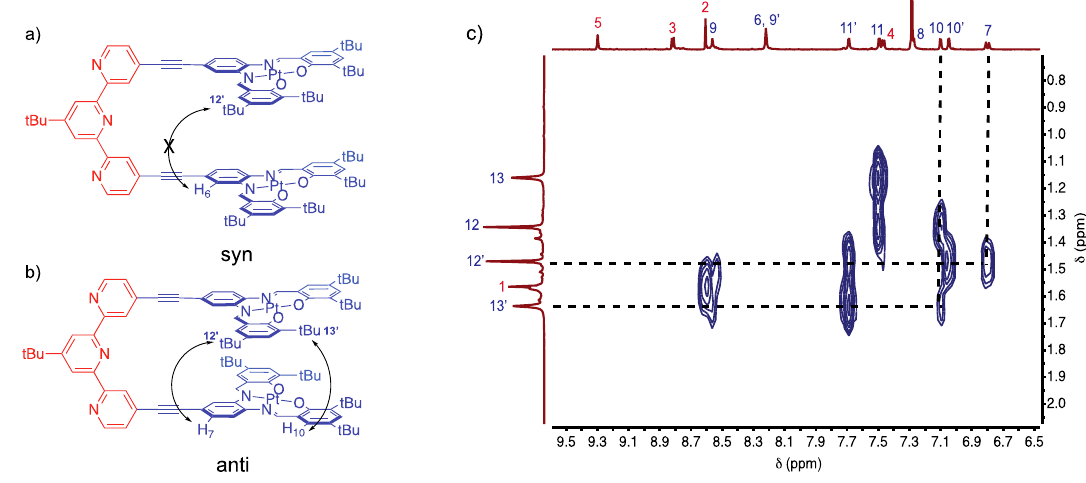
Figure 2. ( a , b ) Molecular structure of the syn - and anti -conformations and ( c ) 1 H NOESY Spectrum (400 MHz, 300 K) of 1 in CDCl 3 showing the correlation peaks between H-7/H-12 ′ and H-10/H-13 ′ indicative of a closed stacked anti -conformation.